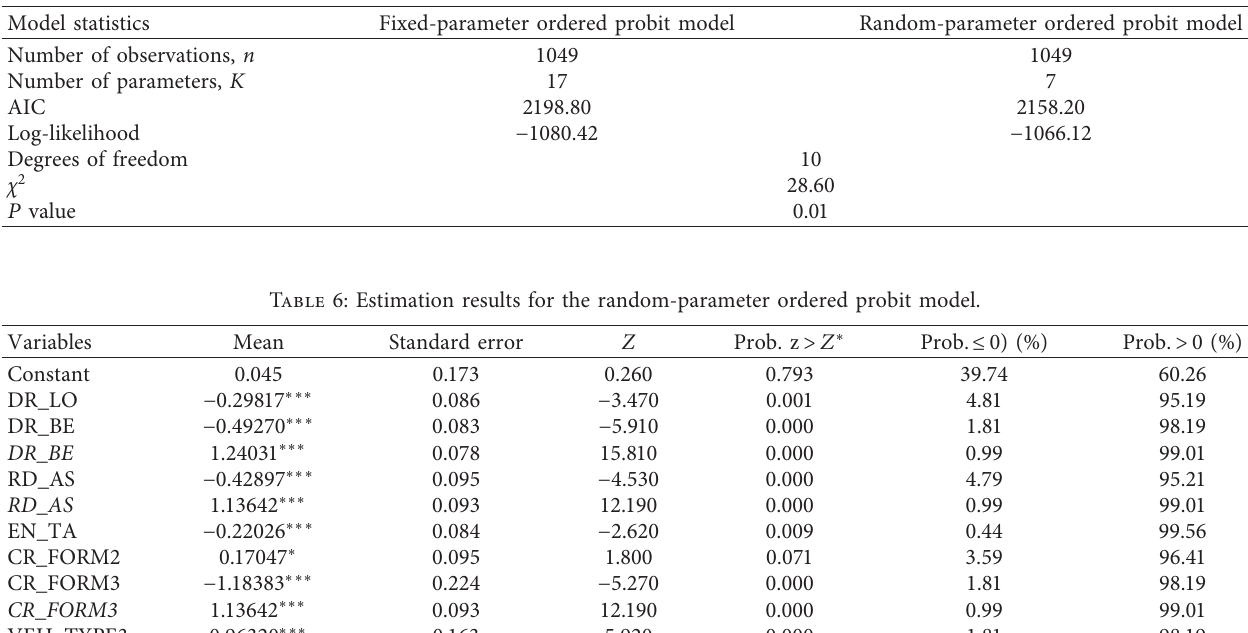
Table 5: Goodness-of-fit measures for fixed- and random-parameter ordered probit